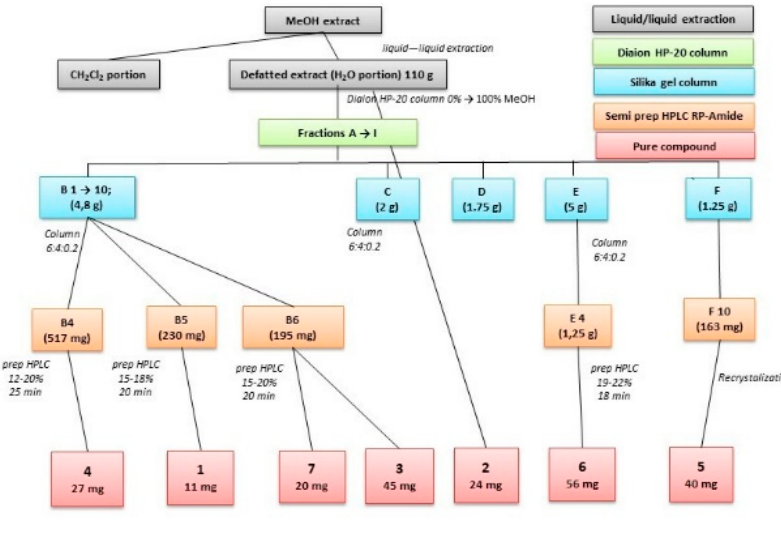
Figure 2. Simplified scheme of separation.